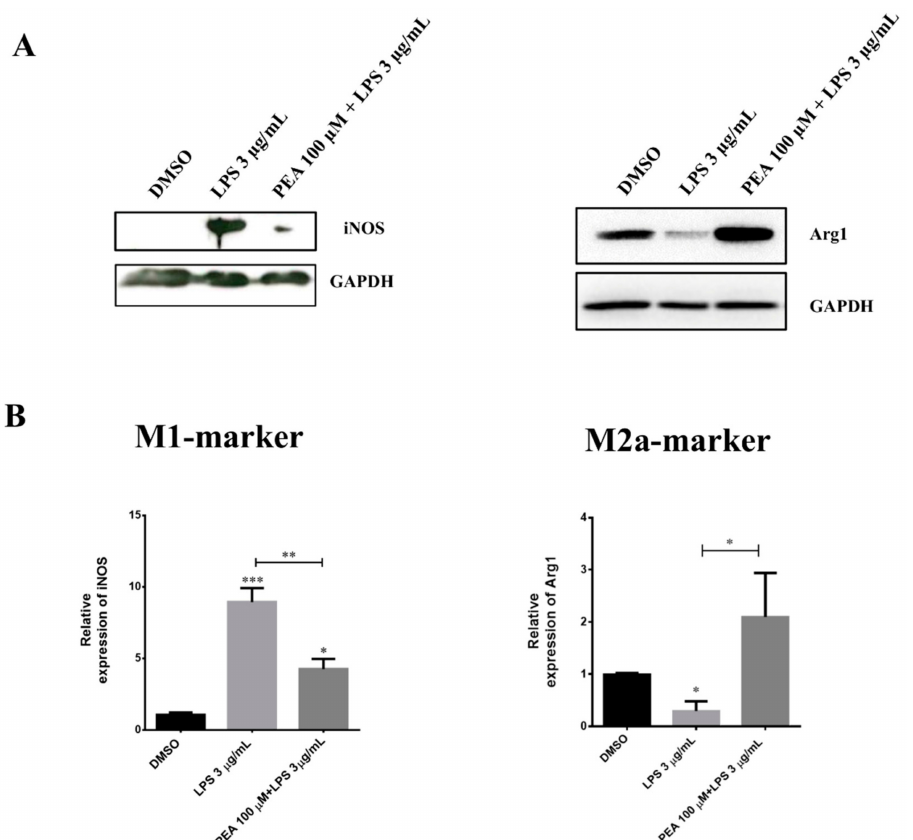
Figure 1. Effect of palmitoylethanolamide (PEA) on M1/M2 markers in lipopolysaccharide (LPS)- stimulated N9 cells. Cells were incubated with 100 µ M PEA at 1 h before treatment with 3 µ g/mL lipopolysaccharide (LPS) for 6 h. Total protein extract from N9 cells were separated on SDS-PAGE and transferred to a polyvinylidene difluoride (PVDF) membrane; membranes were probed with anti-iNOS and anti-Arg1. GAPDH was used to normalize sample loading. Panel ( A ): A representative Western blot is shown. Panel ( B ): Histograms relative to the quantification of bands of inducible nitric oxide synthase (iNOS) and arginase-1 (Arg1) after dimethyl sulfoxide (DMSO), LPS, and PEA + LPS treatments. Data are shown as the mean ± S.E.M. ( n = three independent experiments). Differences among groups were tested for significance by the one-way analysis of variance (ANOVA) followed by Tukey post hoc test (for iNOS) or by Kruskal–Wallis test followed by Dunn’s multiple